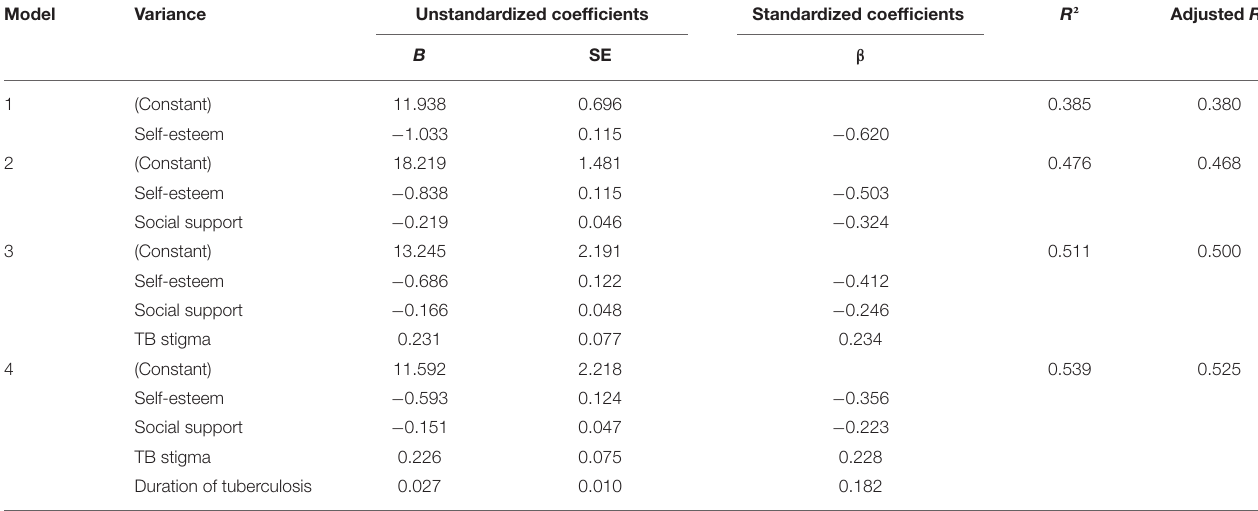
TABLE 4 | Stepwise multiple linear regression results of depression.